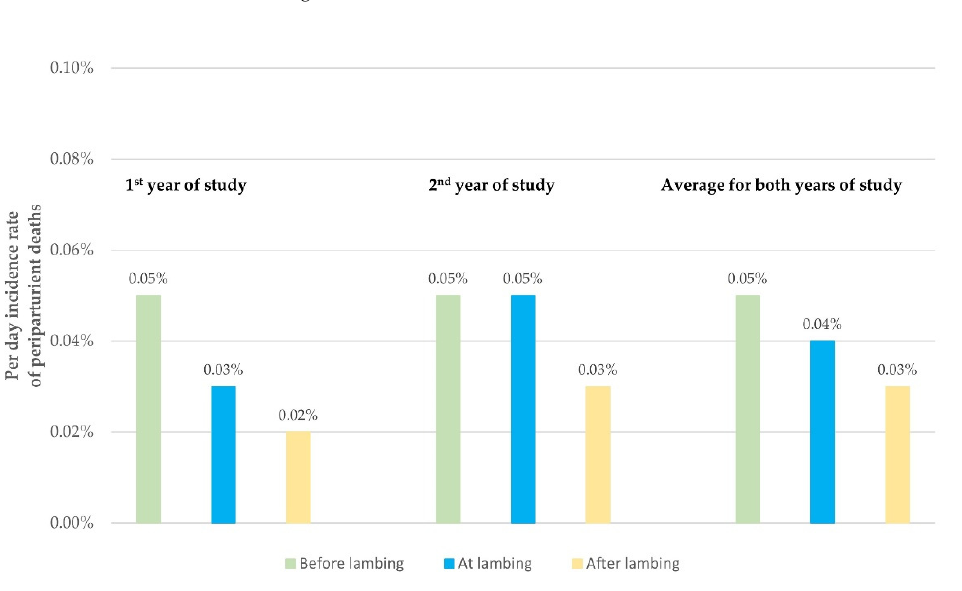
Figure 1. Daily incidence rate of peri-parturient deaths during a two-year study in 60 sheep flocks in Greece in relation to the time of lambing: green, before lambing (duration: 10 days); turquoise, at lambing (duration: 1 day), yellow, after lambing (duration: 7 days).